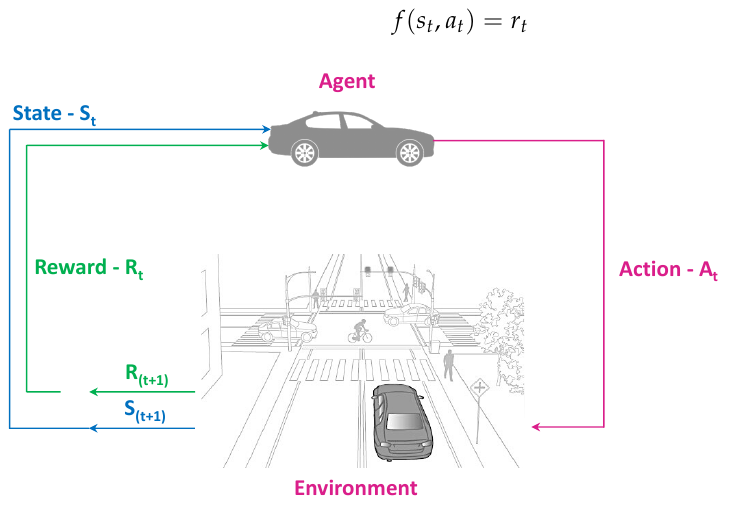
Figure 8. Illustration of Reinforcement Learning